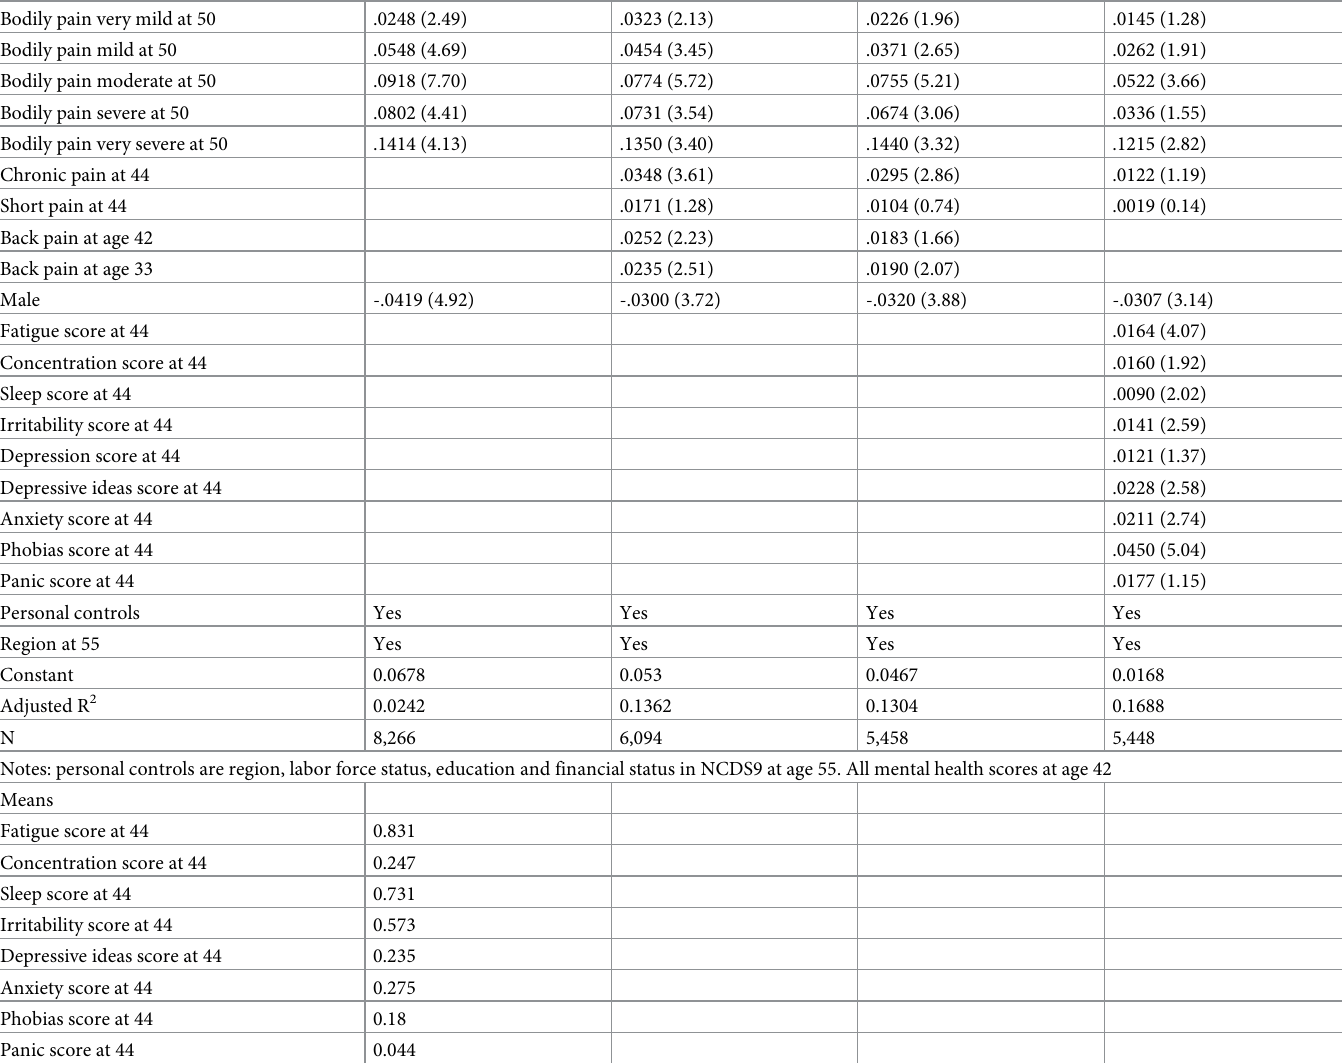
Table 12. Depression, emotional and psychiatric problems since last interview NCDS9 at